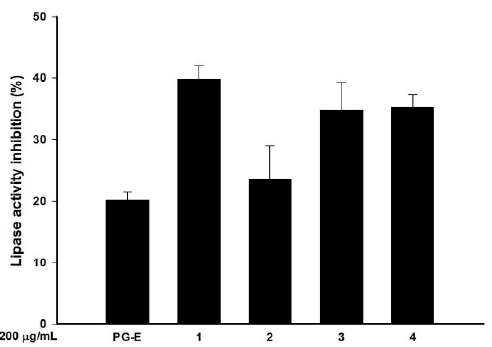
Figure 3. Lipase activity inhibition of pomegranate extract (PG-E) and four hydrolysable tannins included punicalagin ( 1 ), punicalin ( 2 ), strictinin A ( 3 ), and granatin B ( 4 ); The concentration of PG-E, and Compounds 1 – 4 was 200 µg/mL; Data are from three repeats.